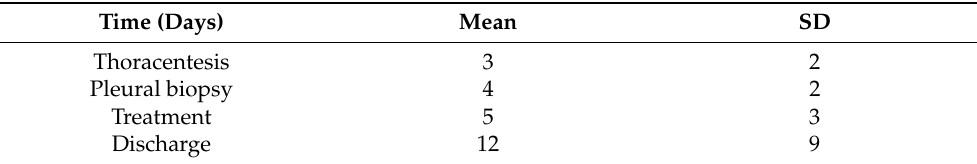
Table 1. Time from hospital admission to diagnostic tests, to beginning of treatment, and to discharge. Time (Days)